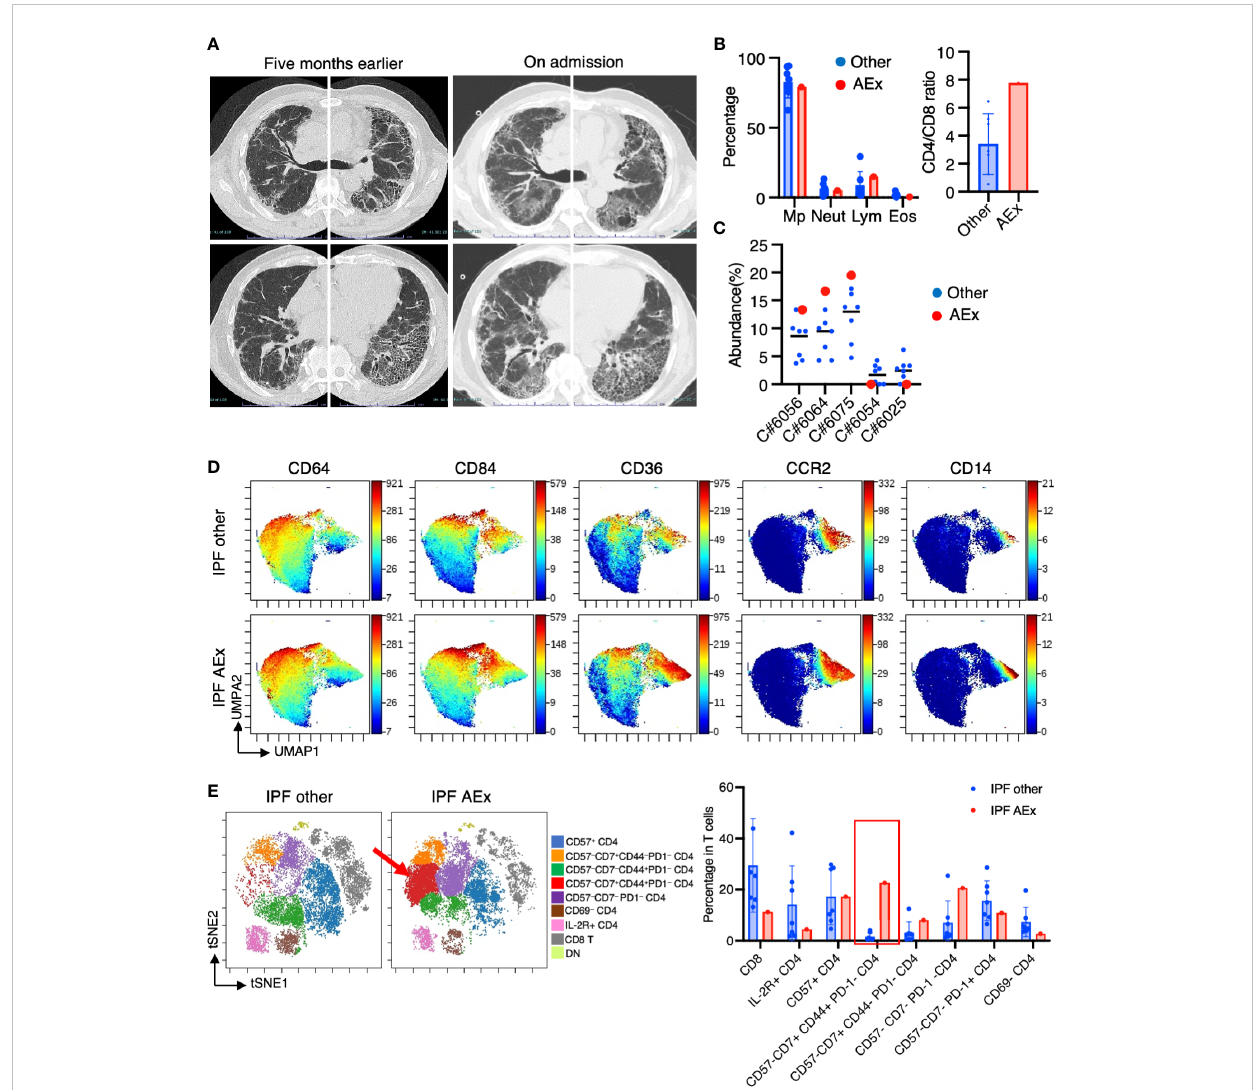
FIGURE 6 Immunological phenotypes in a patient with acute exacerbation of IPF. (A) Chest computed tomography images of the patient upon admission reveal the emergence of bilateral diffuse ground glass opacities superimposed on a honeycomb pattern, accompanied by peripheral traction bronchiectasis primarily in the basal lungs. (B) Comparison of BALF cell differentiation and CD4/CD8 ratio between patients with a patient experiencing an acute exacerbation (AEx) of the condition and the other cases of IPF. (C) Citrus-generated plots for myeloid sub-populations in IPF patients with stable condition and AEx. Each cluster number (C#) corresponds to the number shown in Figure 2C. (D) A uniform manifold approximation and projection (UMAP) of myeloid cells (CD45 + CD11b + CD11c + gated) showing cell distributions and each marker expression in BALF cells from concatenated samples with AEx and other cases of IPF. (E) t-SNE plots visualizing the distribution of T cell subpopulations in BALF T cells (gated as CD45 + CD2 + CD3 + ) from patients with AEx and other cases of IPF. Double negative (DN) T cells were de fi ned as CD4 – CD8 – T cells. A red arrow indicates expansion of the CD57-CD7+CD44+PD-1-CD4 T cell subpopulation in